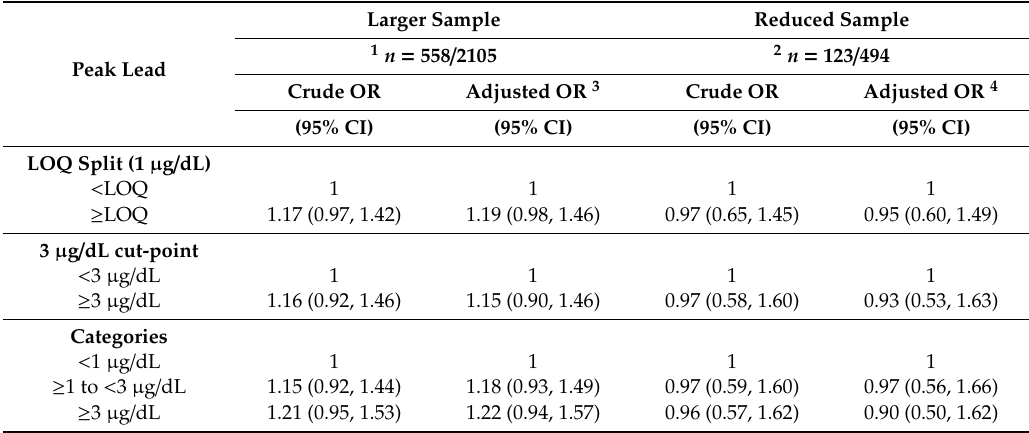
Table 3. Crude and adjusted risk estimates of respiratory syncytial virus (RSV) comparing cases with controls by peak blood lead concentrations among larger and reduced